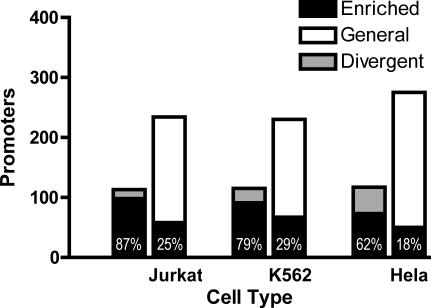
Number and Percentage of Divergent and General Promoters Bound by GABP in Three Different Cell TypesPromoters with observed enrichment of 3-fold or more by ChIP-qPCR were considered bound and are depicted as the dark portion of each bar. The majority of divergent promoters are bound by GABP in all three cell types, compared to a much smaller fraction of general promoters.